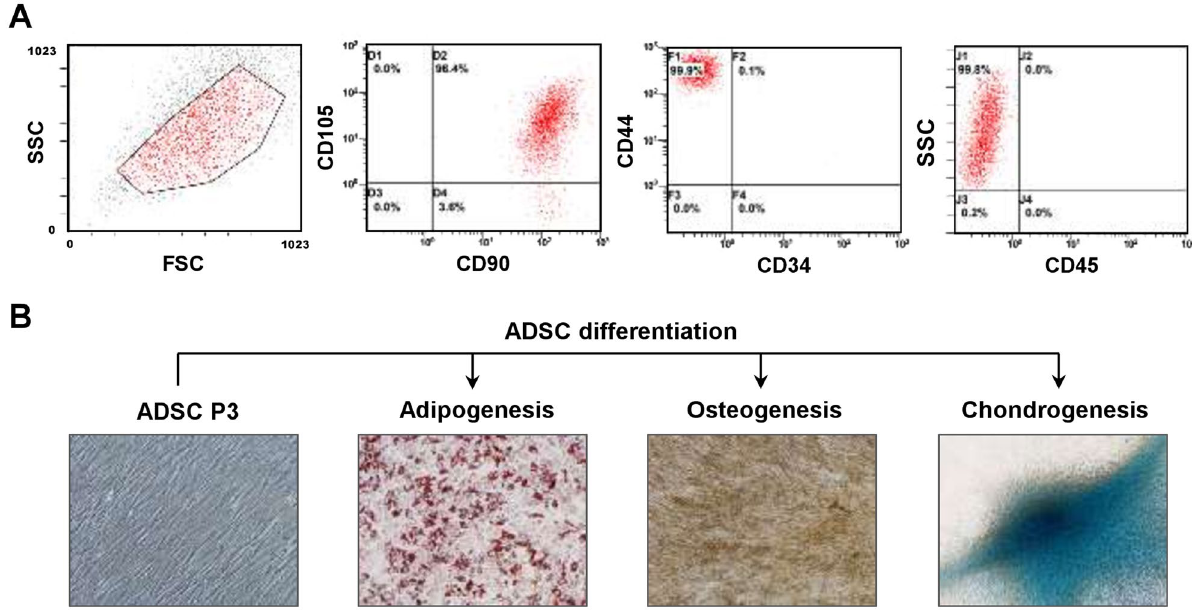
Figure 1. Characterization of isolated ADSC phenotypes and the potential for lineage-specific differentiation. ( A ) The ADSCs isolated from adipose tissues adjacent to breast tumors were characterized by the expression of mesenchymal stem cell markers (CD44, CD90, and CD105) or hematopoietic lineage markers (CD34 and CD45). After culturing for three passages, the ADSCs showed the expression of CD44 + /CD90 + /CD105 + /CD34 – / CD45 – cell surface markers which were analyzed by flow cytometry. ( B ) Representative images showed the undifferentiated ADSCs at passage 3 (ADSC P3), and these ADSCs were able to be induced to differentiate into three different cell lineages: adipocytes (adipogenesis), osteocytes (osteogenesis), and chondrocytes